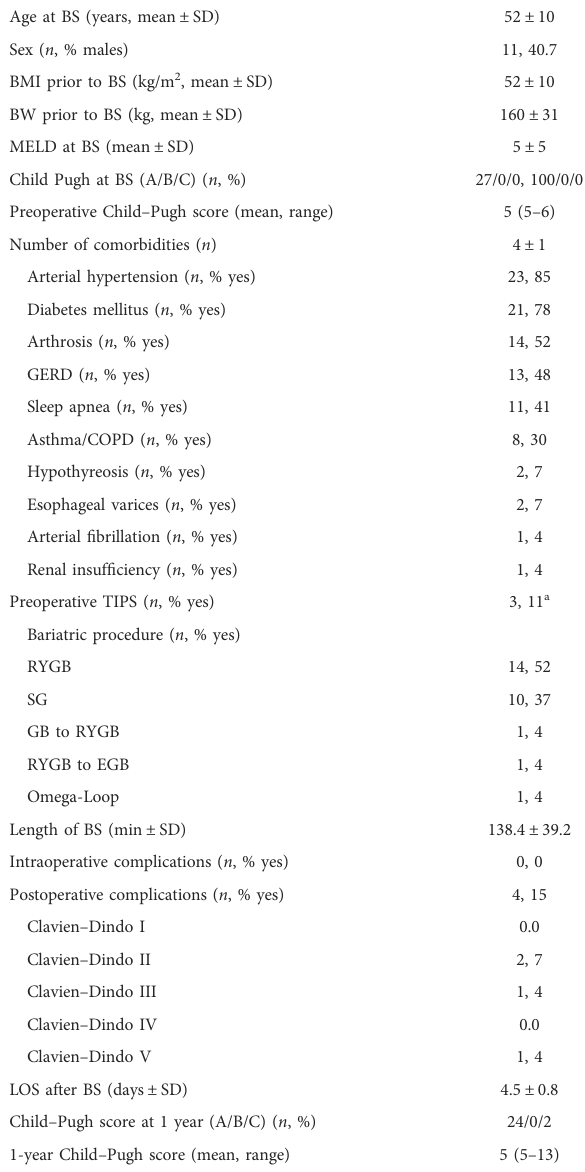
TABLE 1 Patients undergoing BS suffering from liver cirrhosis ( n =27). BS in patients suffering from liver